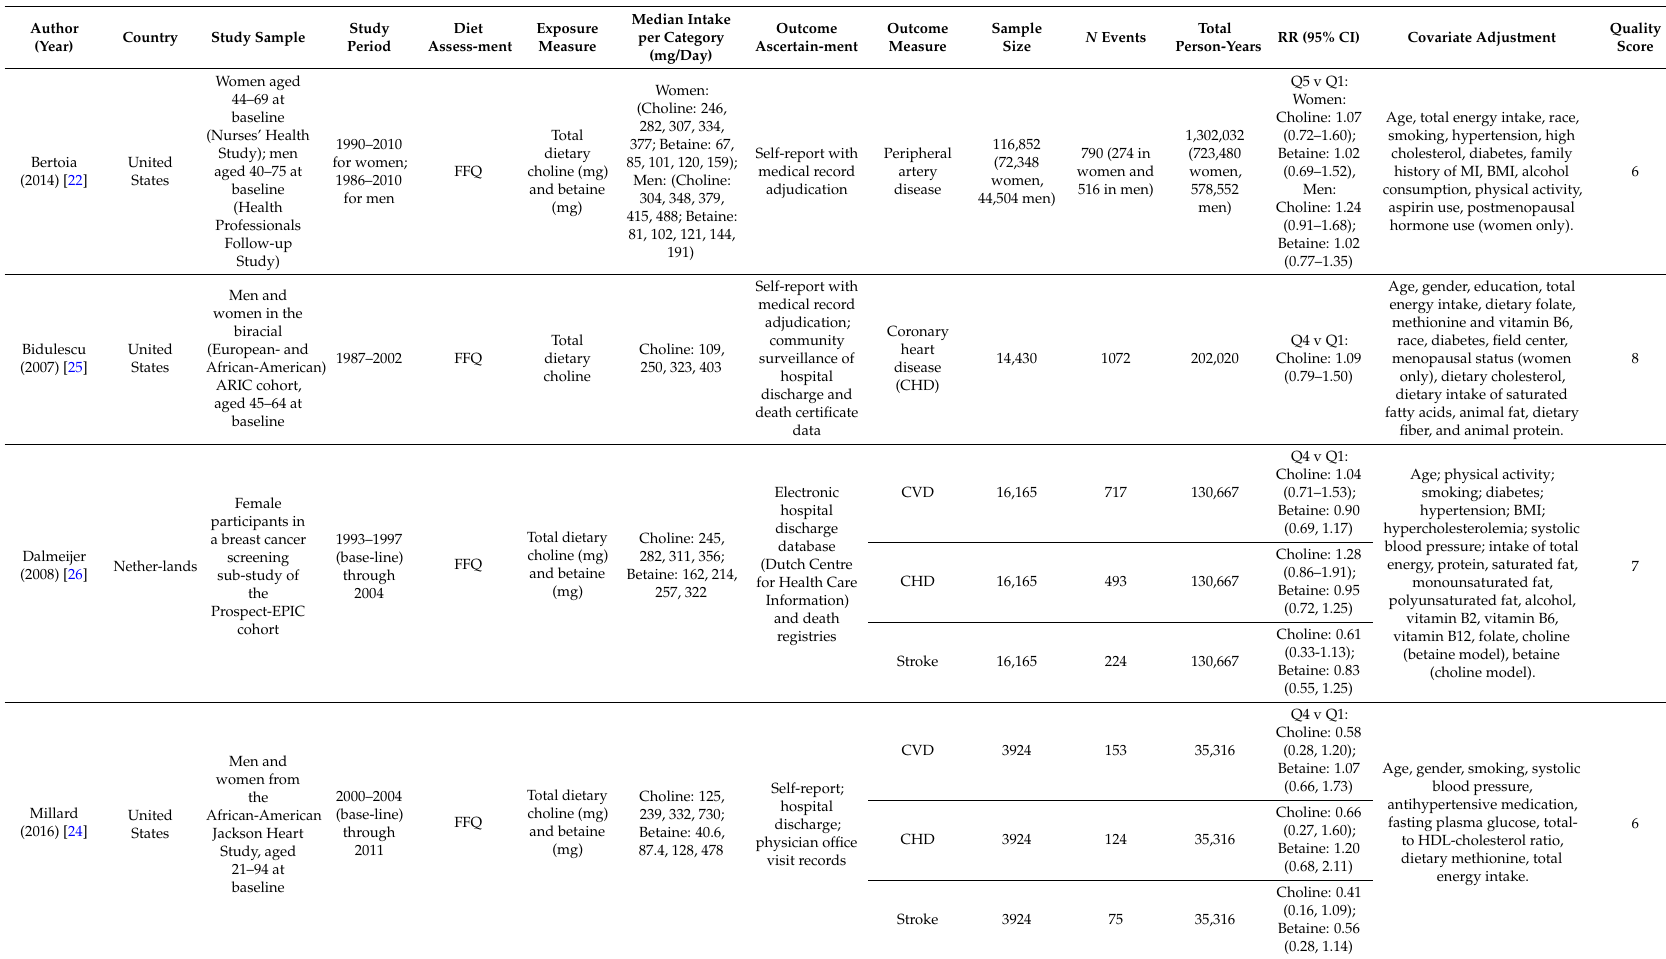
Table 1. Characteristics of six prospective cohort studies reporting the association between dietary choline or betaine and cardiovascular